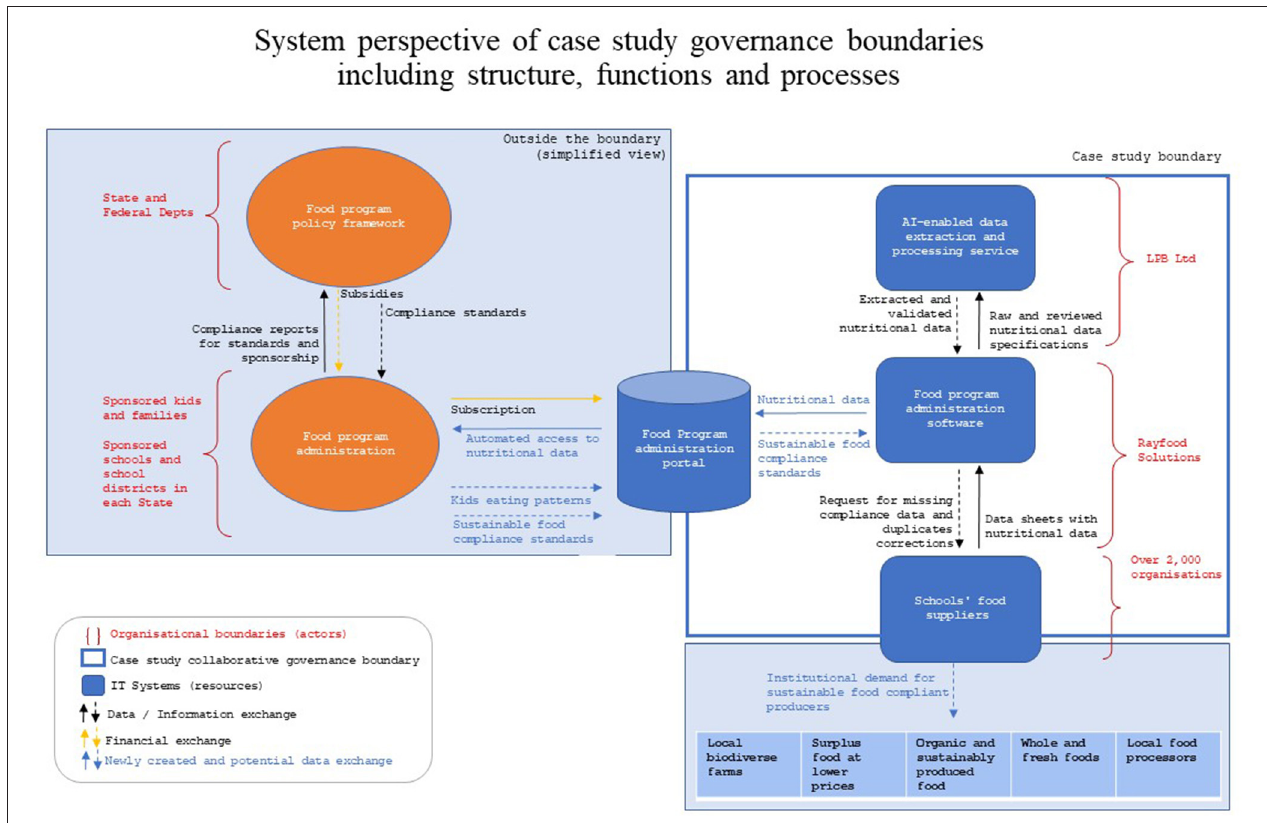
FIGURE 6 | System perspective of case study governance boundaries including structure, functions and